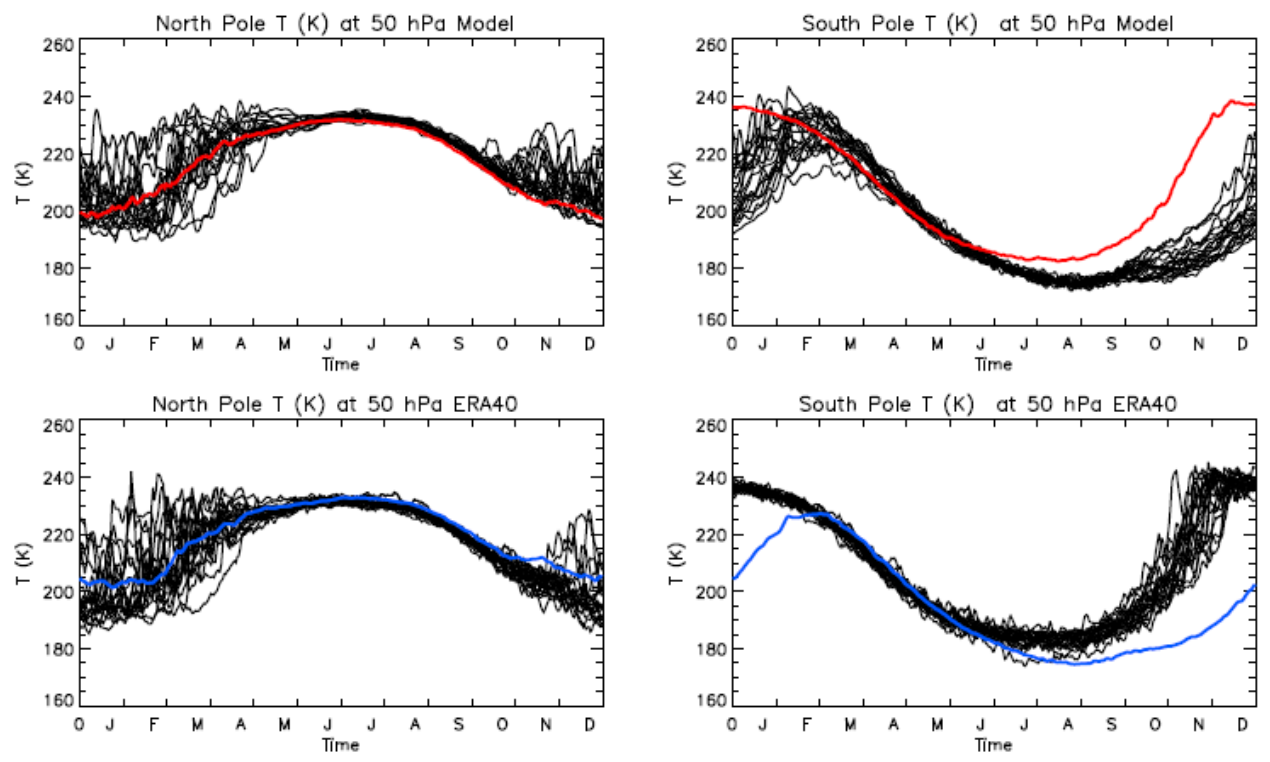
Fig. 3. Polar temperatures at 50hPa and for 20 years (1980–1999) in LMDz (top) and in the ERA 40 ECMWF reanalysis (bottom) for the Northern Hemisphere (right), and the Southern Hemisphere (left). The mean value over the 20 years are in red for ECMWF reanalysis and in blue for LMDz.